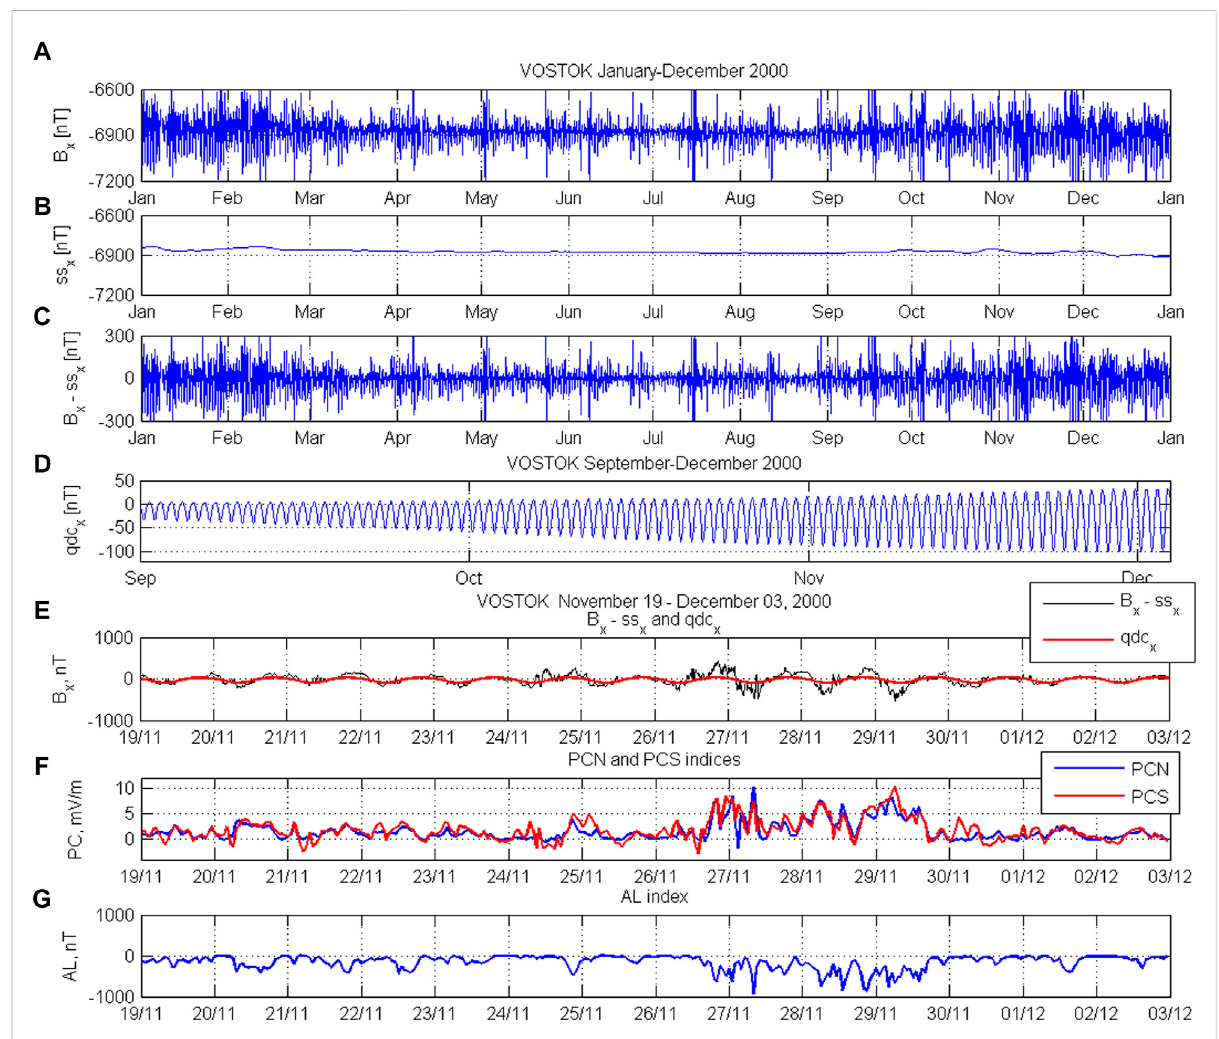
FIGURE 4 (A – D) Four stages of the “ running QDC calculation ” procedure (on the example of geomagnetic X component); (E) Run of geomagnetic quantity δ X = B x -ss x (black line) and the appropriate quiet daily variation QDC x (red line) at Vostok station in November 2000; corresponding alternations of the appropriate PCN and PCS indices (F) and AL index (G) for period from 19 November 2000 to 02 December